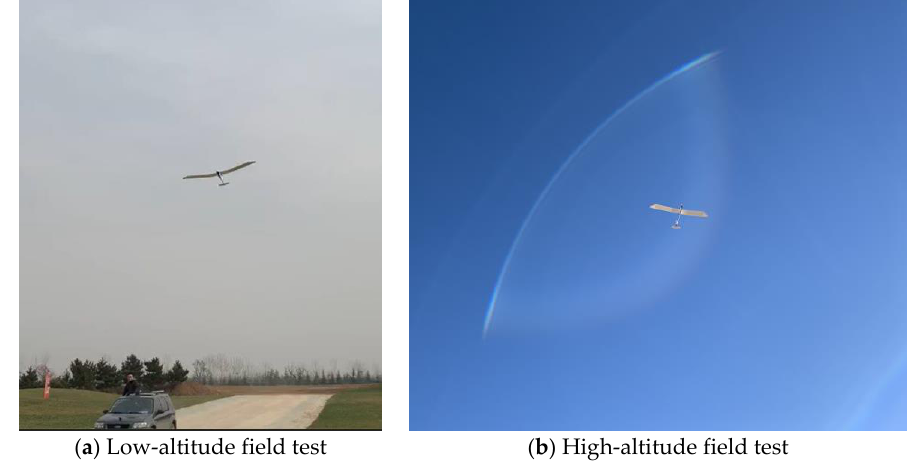
Figure 20. Real flight test in low and high altitudes.